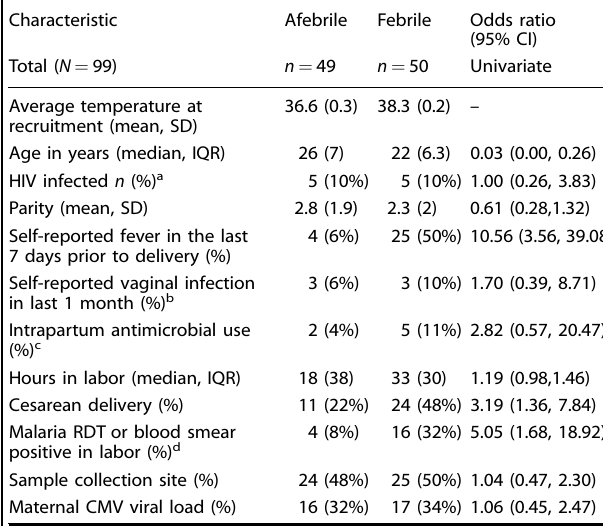
Table 1. Overview clinical characterization of febrile vs.